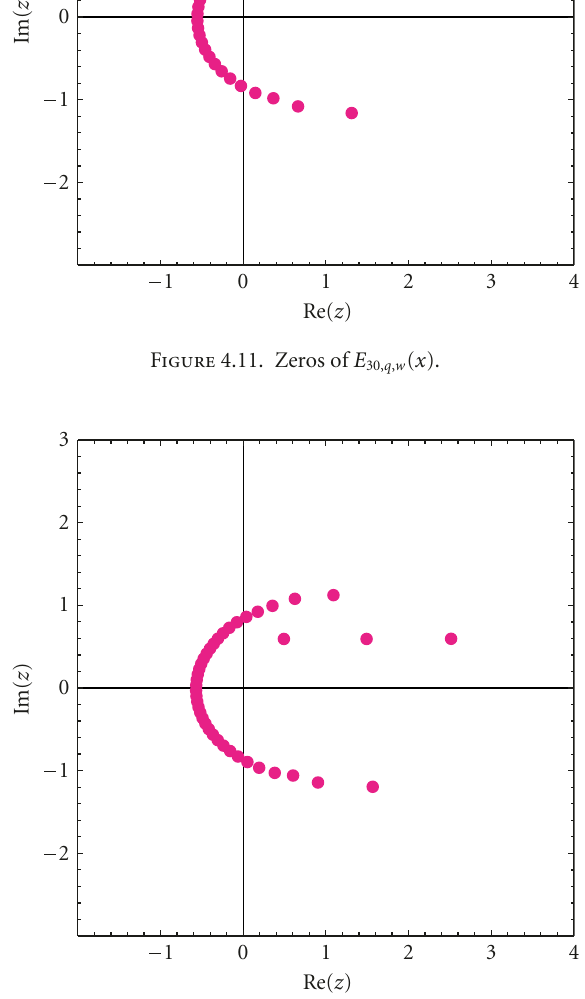
Figure 4.12 . Zeros of E 40, q , w ( x